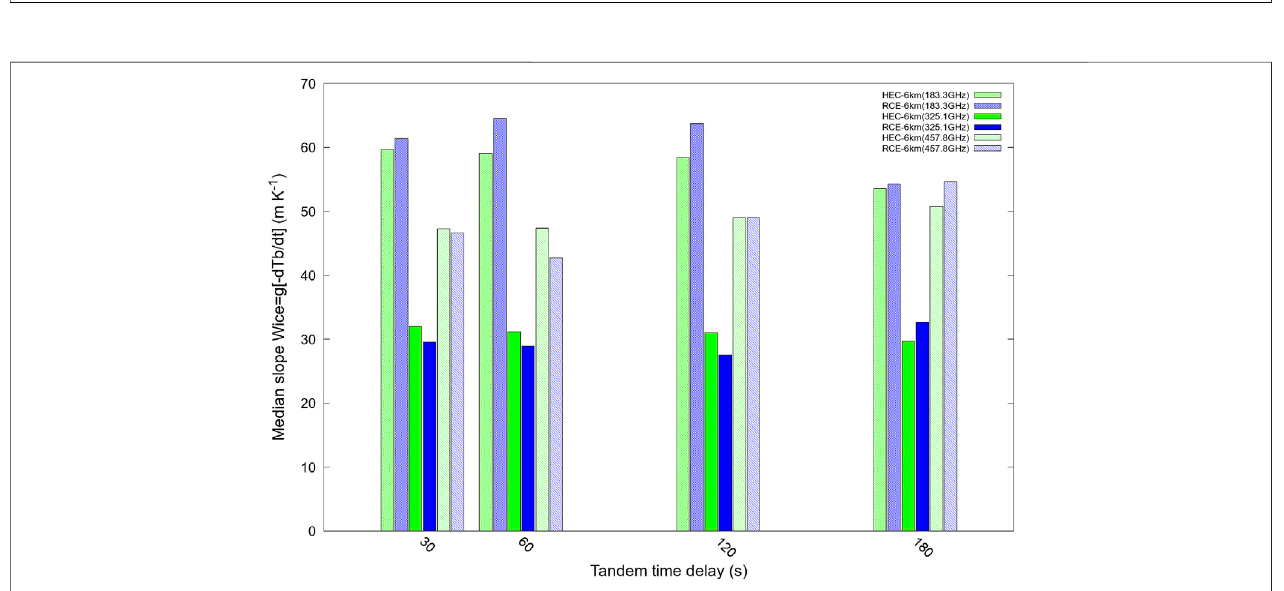
FIGURE 11 | Same as Figure 9 but for w ice at the 6-km resolution. Results are shown for grid points verifying the growing convective core criterion.